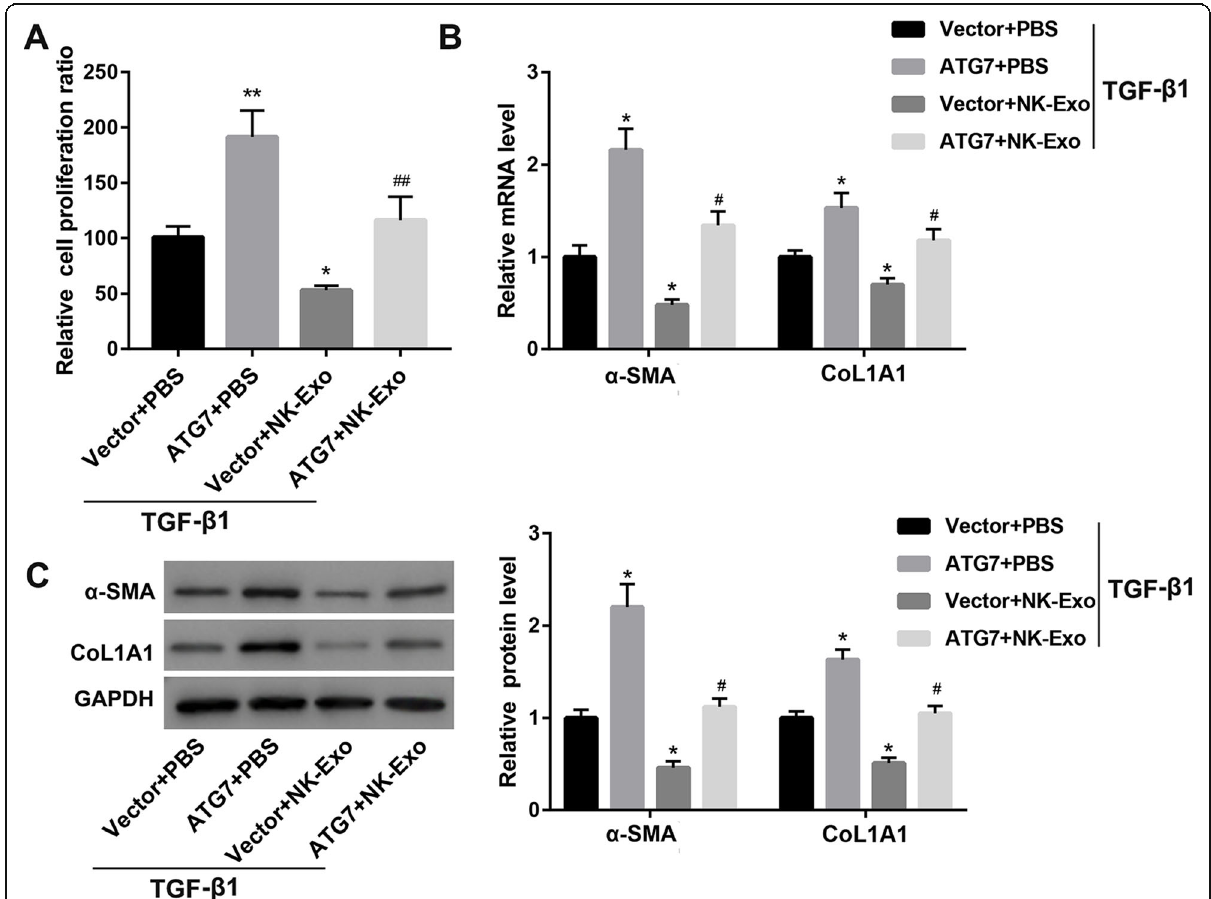
Fig. 4 NK-Exo attenuated TGF- β 1-induced HSC activation by inhibiting ATG7 expression. Cell proliferation ratio determined by CCK-8 assay (a) , the mRNA (b) and protein (c) levels of α -SMA and CoL1A1 in LX-2 cells transfected with ATG7 overexpression vector/empty vector followed by treatment with NK-Exo/PBS in the presence of TGF- β 1. * P < 0.05, ** P < 0.01 vs. TGF- β 1 + Vector+PBS; # P < 0.05, ## P < 0.01 vs. TGF- β 1 + Vector+NK- Exo. The data are presented as the mean ± standard deviation (n =